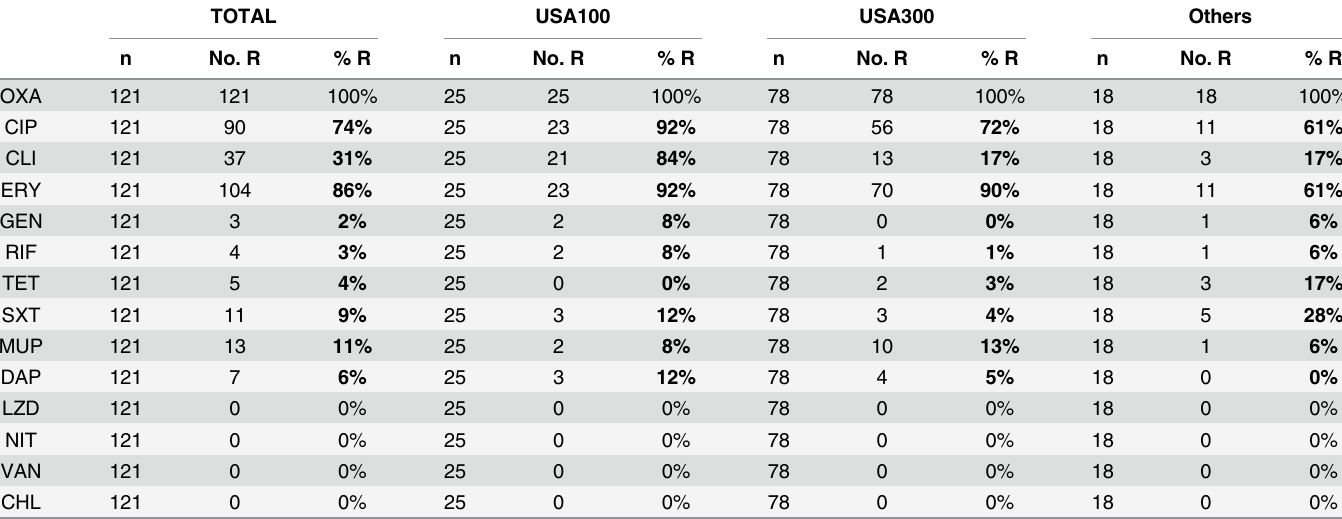
Table 2. Antimicrobial resistance profiles of strains characterized in the